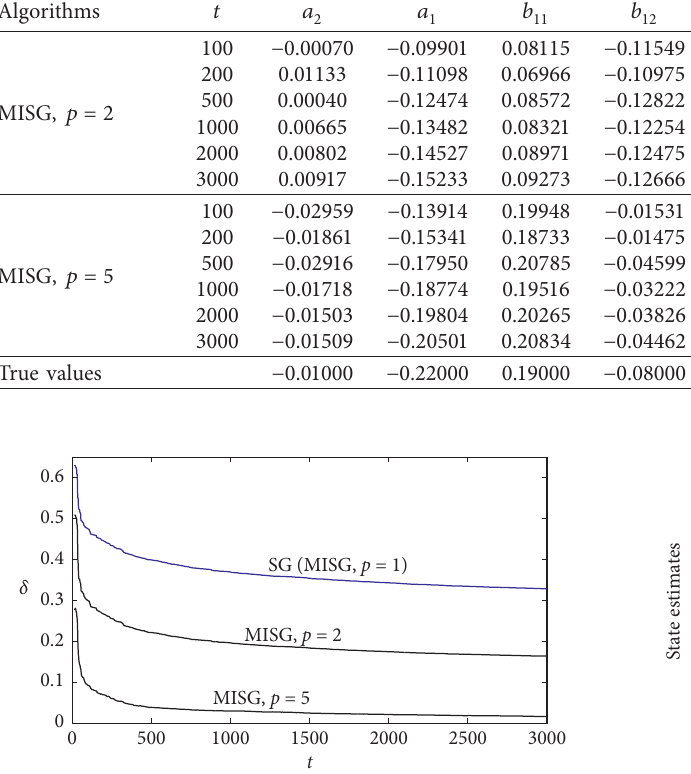
Figure 1: The parameter estimation errors δ versus t with σ 2 � 0 . 30 2 .